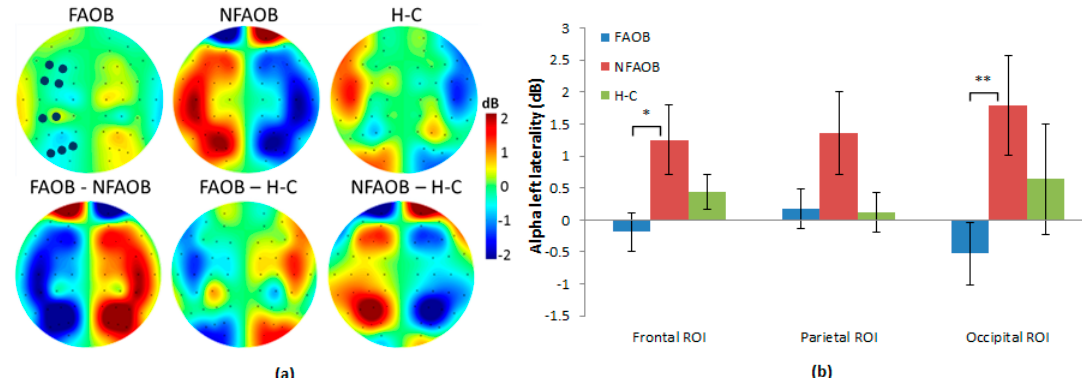
Figure 2. Group di ff erences in brain alpha asymmetry. ( a ) Topographic plots of the mean group left alpha asymmetry power (upper row) and the group contrasts (lower row), for the FAOB, NFAOB, and H-C groups. Note that the maps are based on subtraction of alpha power between symmetric electrode pairs and are thus left / right mirrored. ( b ) Mean and SEM of left alpha asymmetry power for each group in the frontal, parietal and occipital ROI. Electrodes included in each ROI are marked in dark blue in 2a. * p ≤ 0.05; ** p ≤ 0.01. FAOB: overweight and obese with food addiction. NFAOB: overweight and obese without food addiction. H-C: healthy controls. SEM: standard error of mean. ROI: region of interest.